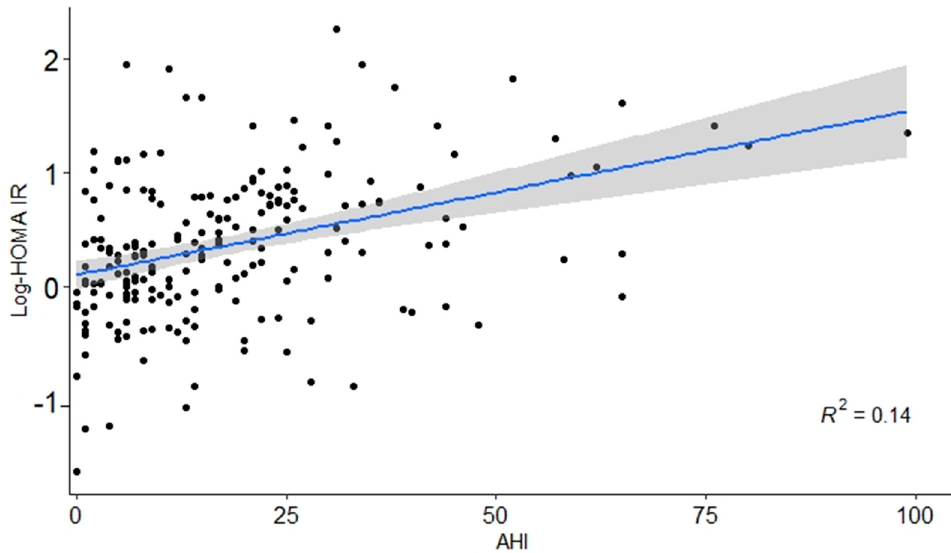
Figure 1. Linear regression between AHI (Apnea-hyponea index) and HOMA-IR (Homeostasis model of assessment for